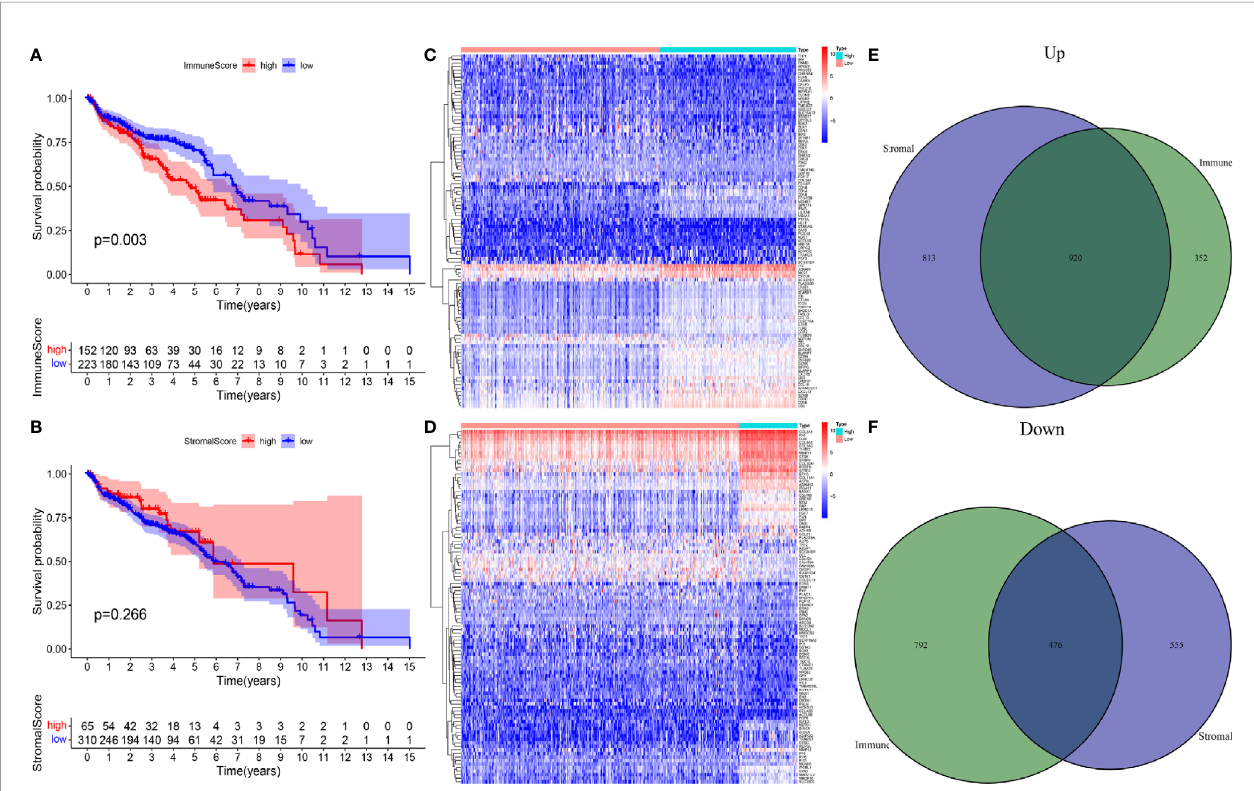
FIGURE 1 | (A) A survival curve based on immune score for patients in the HRG and LRG. (B) A survival curve based on stromal score for patients in the HRG and LRG. (C) Heatmap plots of DEGs in immune score of OC. (D) Heatmap plots of DEGs in stromal score of OC. (E) Venn diagram depicting the number of upregulated DEGs based on two scores. (F) Venn diagram depicting the number of downregulated DEG based on two